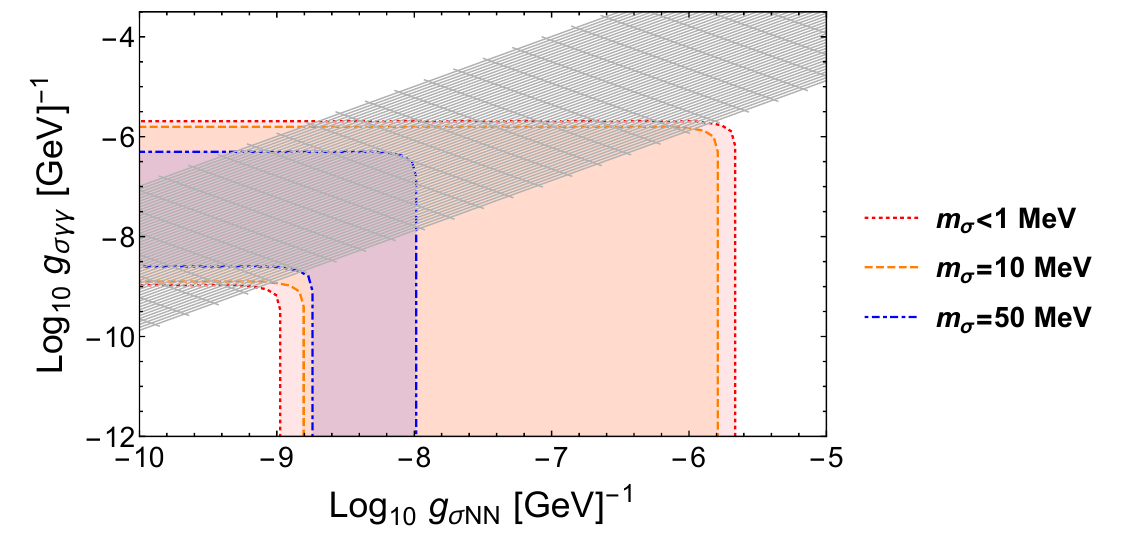
Figure 6. Exclusion region by SN 1987a in the g (cid:27)(cid:13)(cid:13) (cid:0) g (cid:27)NN space. The bound on g (cid:27)(cid:13)(cid:13) are obtained approximately from (cid:12)gure 1. In the case that g (cid:27)(cid:13)(cid:13) provides the dominant contribution to g (cid:27)NN the relation in eq. (4.31), is plotted for 0 : 01 < j b EM